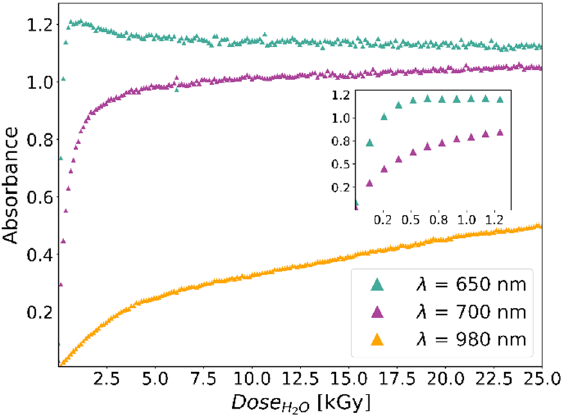
Figure 7. Absorbance as a function of the dose for the dosimeter with an HDV-2 gafchromic film for the dose measurement of the radiation field from a 19.9 MeV proton beam. The inset shows a zoom of the graph in the dose range of 0–1.3 kGy.